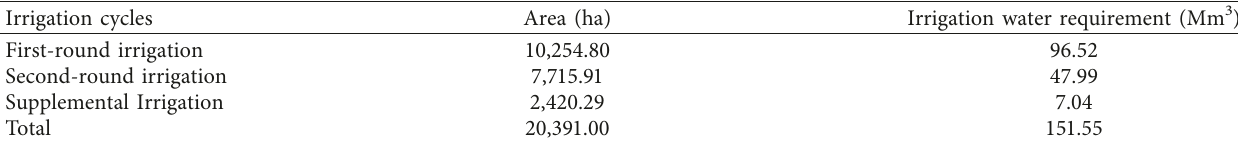
Table 12, and the estimated current water use GIS map of the subbasin is quantified in raster calculator by IDW method